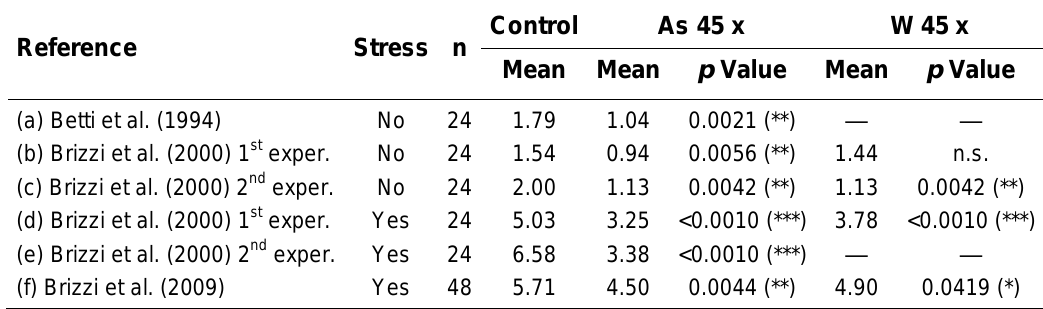
Wheat Germination Model: Mean Number of Nongerminated Seeds and Poisson Test Significance